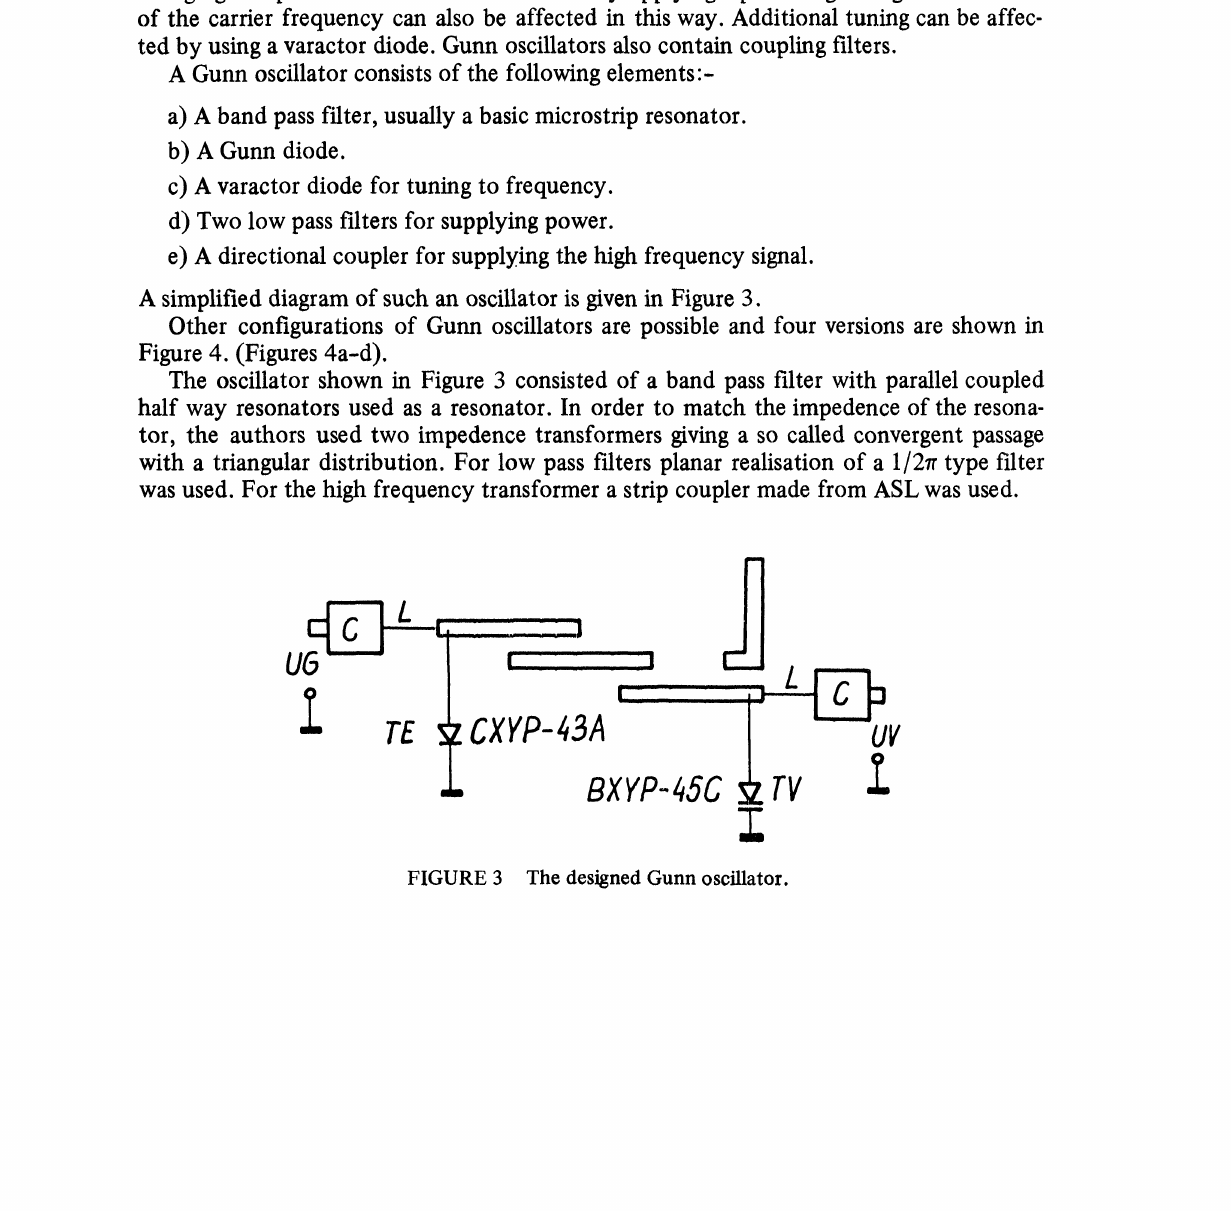
FIGURE 3 The designed Gunn